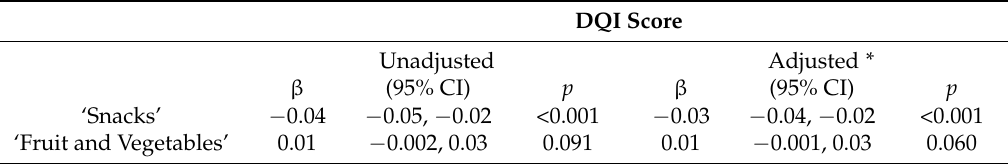
Table 3. Associations between children dietary patterns and parent Diet Quality Index Scores. DQI Score Unadjusted β (95% CI) β (95% CI) p ‘Snacks’ − 0.04 − 0.05, − 0.02 <0.001 − 0.03 − 0.04, − 0.02 <0.001 ‘Fruit and Vegetables’ 0.01 − 0.002,